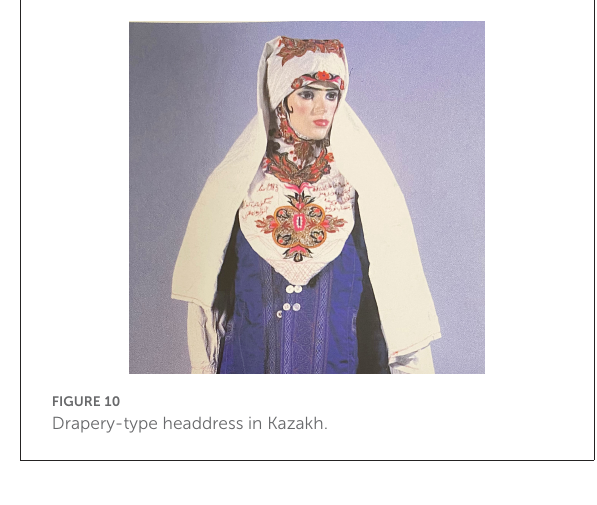
FIGURE8 Burqa in Afghanistan and Iran.